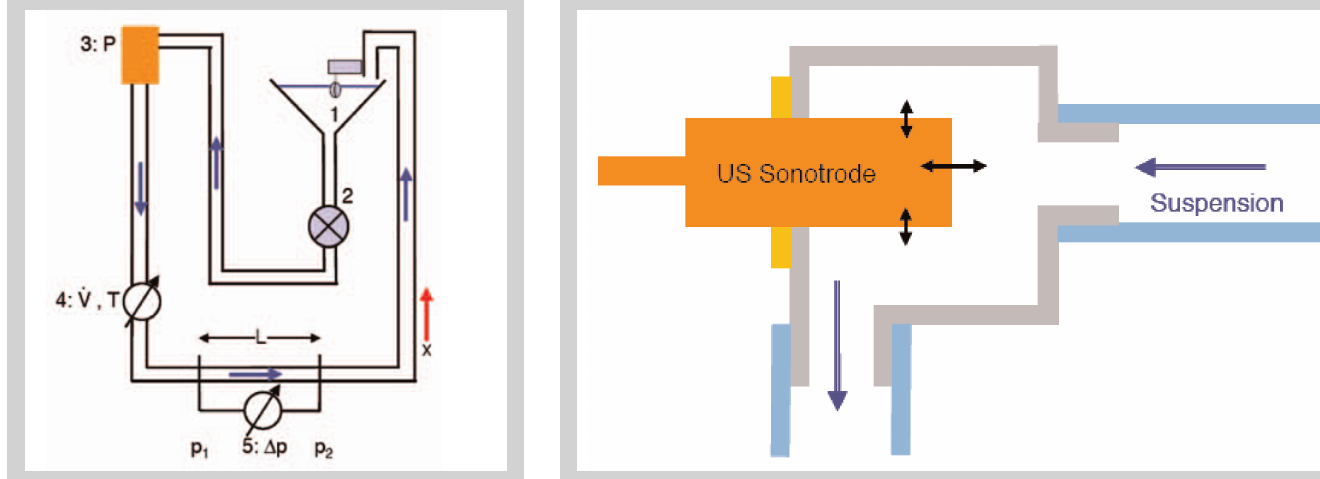
Figure 1 (left): Schematic of the set-up for the pump experiments (x: co-ordinate in flow direc- tion, 1 storage vessel with stirrer (10 l), 2 mohno pump Nemo NM021, 3 ultrasonic flow cell UIP500 with ener- gy input sensor and ther- mometer, 4 inductive flow- meter, 5 two pressure sensors (HBM GmbH, Darm- stadt, Germany). Figure 2: Schematic of the used flow cell (20 kHz, Pmax = 500